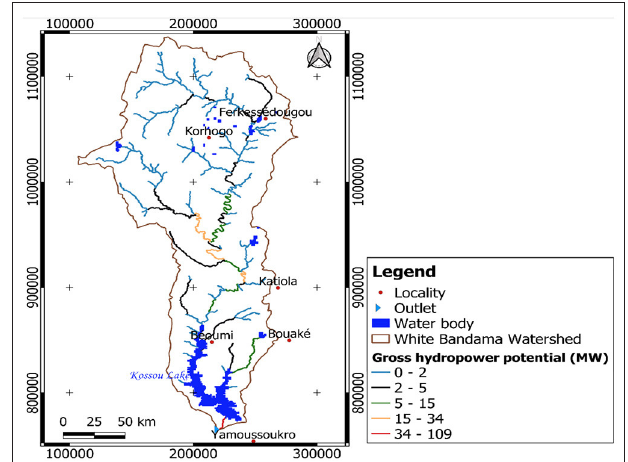
FIGURE 10 | Assessment of the gross hydropower potential of the WBW.